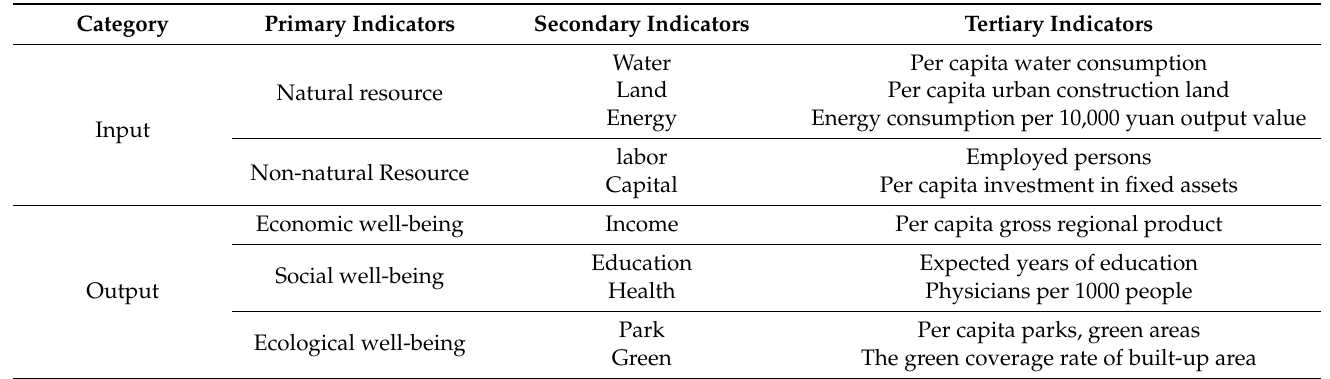
Table 2. Ecological well-being performance measurement index